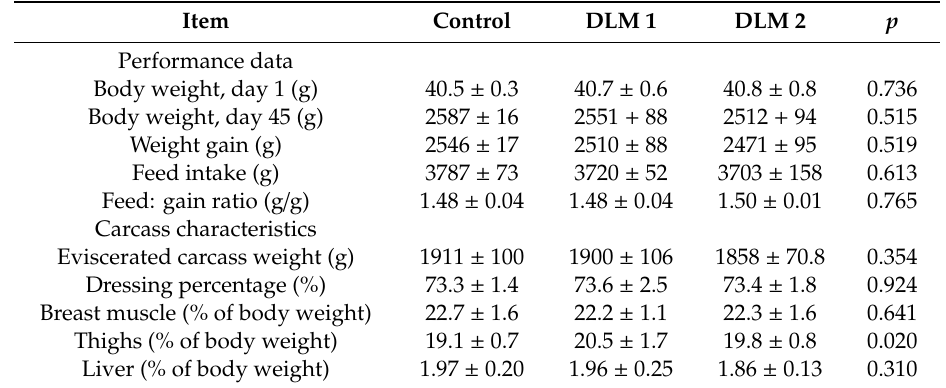
Table 3. Performance data and carcass characteristics of broilers fed a control diet (control) or